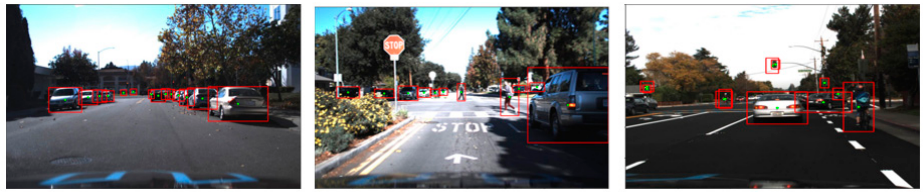
Figure 6. Training data sample images and visualized labels. The red boxes in the images are the ground truth locations of the target objects.